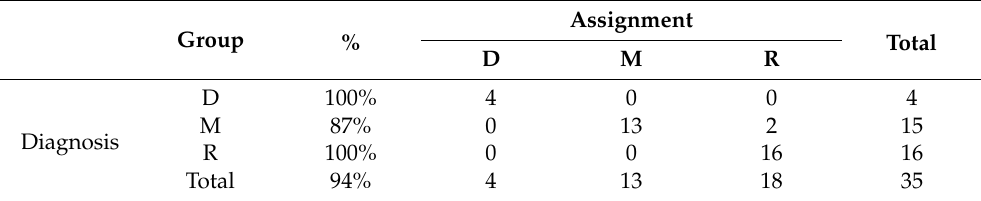
Table 3. Obtained classification matrix for matching fibres by multivariate discriminate analysis for 30% of randomly selected fibres, which were not involved in creating the model. Abbreviations: D—dystrophies group; M—myopathy group; R—reference